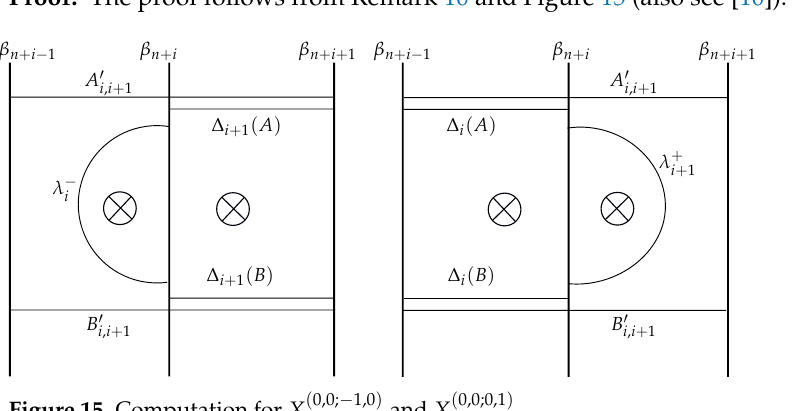
Figure 15. Computation for X